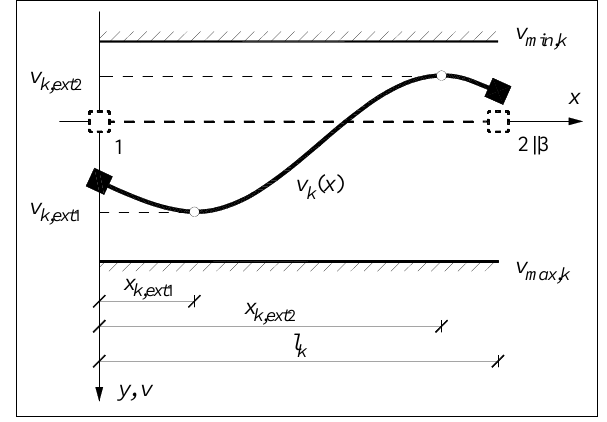
Fig. 4. Extreme deflections of the BEAM31